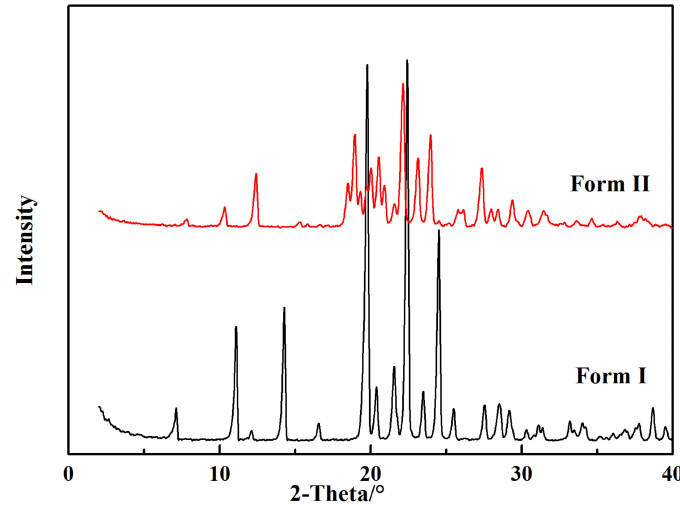
Figure 3. Powder X-ray diffraction patterns of L-carnosine form I and form II.